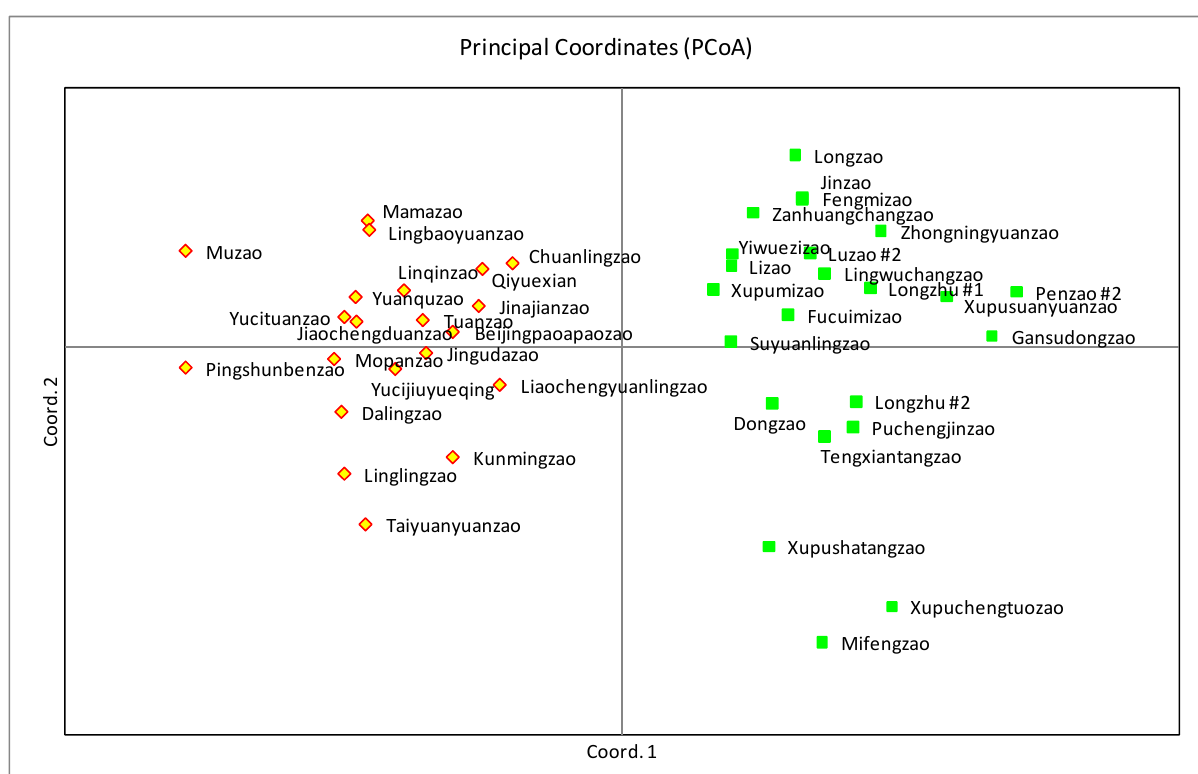
Genetic relationships among the analyzed jujube accessions are presented in the princi- pal coordinates analysis (PCoA) plots (Figure 5). The two core member groups assigned by the Bayesian clustering analysis were clearly distinguished without overlapping, showing the different genetic background between these two groups of cultivars. However, the geographical pattern was not clearly reflected in the PCoA.